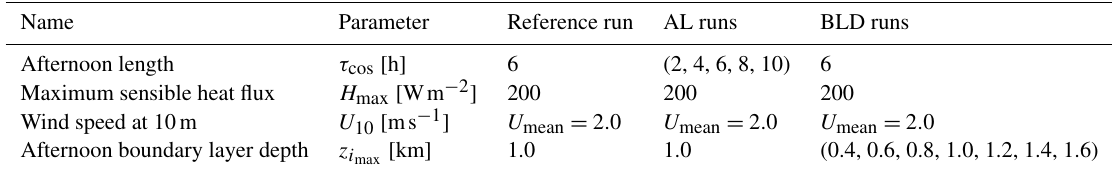
Table 2. Simulation settings for model experiment test runs.